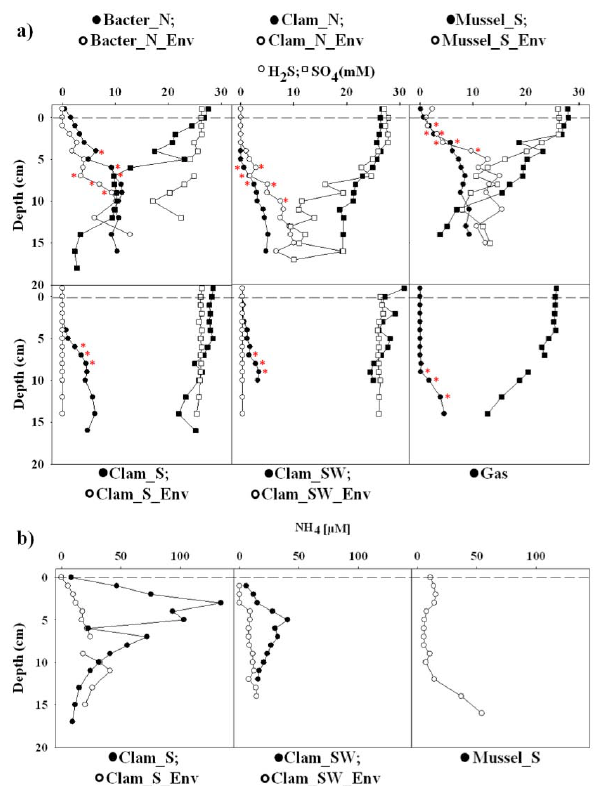
Fig. 3. Geochemical depth profiles of sulphide (circles) and sul- phate (squares) (a) , as well as ammonium (b) measured at the dif- ferent habitats at REGAB. Closed symbols denote measurements taken within the patches/bacterial mat, and open symbols denote measurements taken at the nearby bare sediments. Red star sym- bol (*) denotes the concentration gradients used for calculating the sulphide fluxes presented in Table